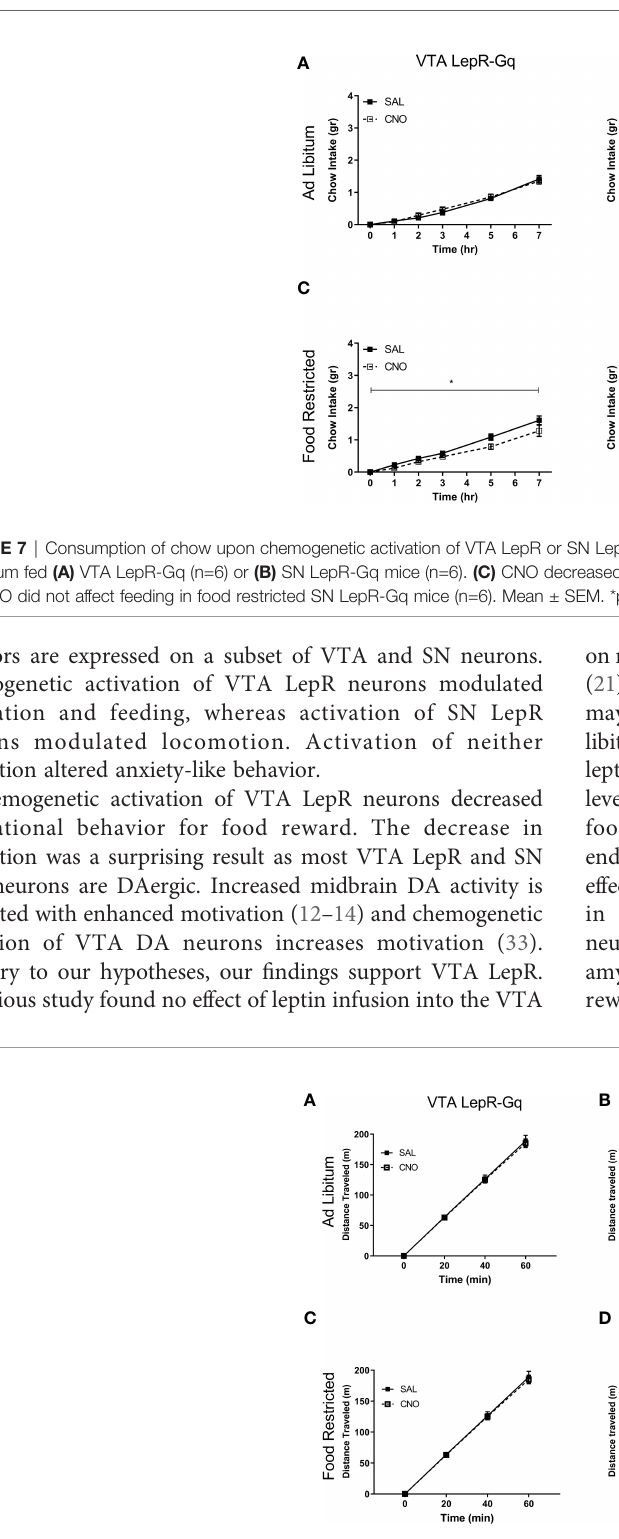
FIGURE 8 | Locomotor activity upon chemogenetic activation of VTA LepR or SN LepR neurons. Locomotion was not affected by CNO (1.0mg/kg) injections in ad libitum fed (A) VTA LepR-Gq (n=6) and (B) SN LepR-Gq (n=6) or (C) food restricted VTA LepR-Gq mice (n=6). (D) CNO decreased locomotion in food restricted SN LepR-Gq mice (n=6). Mean ± SEM. *p<0.05.